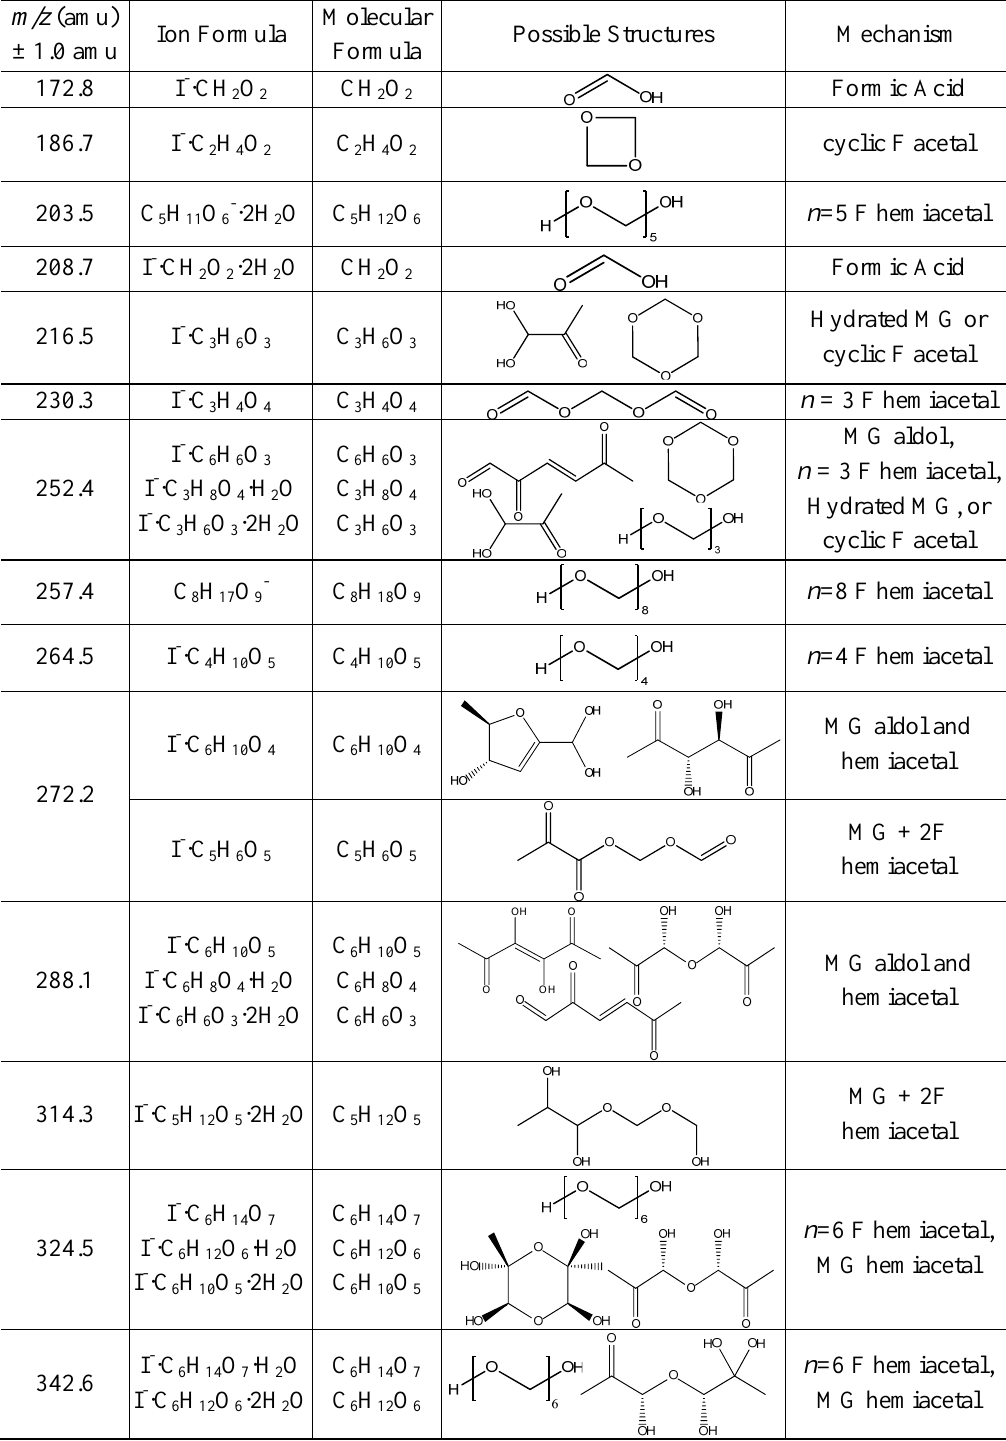
Table 3. Proposed peak assignments for Aerosol-CIMS mass spectra with I − of atomized solutions of 2M formaldehyde/MG (1:1) in 3.1MAS.